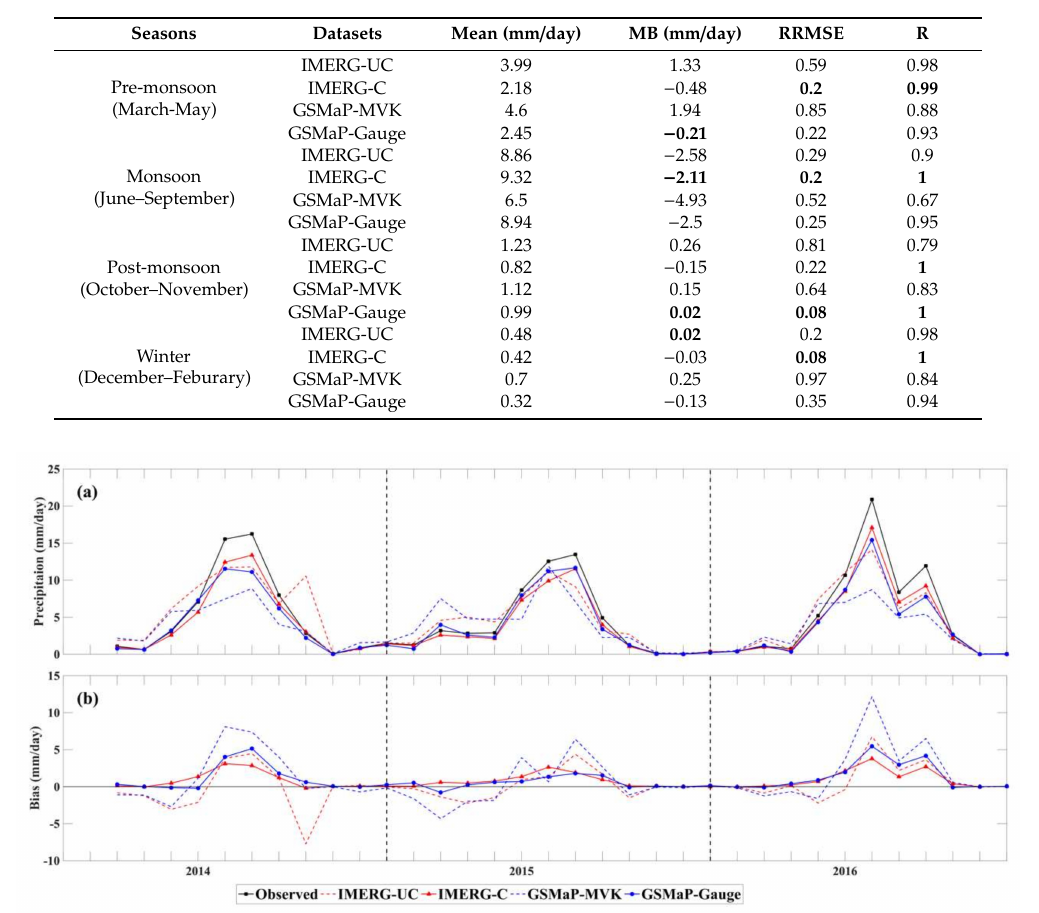
Figure A1. ( a ) The timeseries of monthly mean precipitation and ( b ) Bias between observed and four SBP datasets averaged over the study